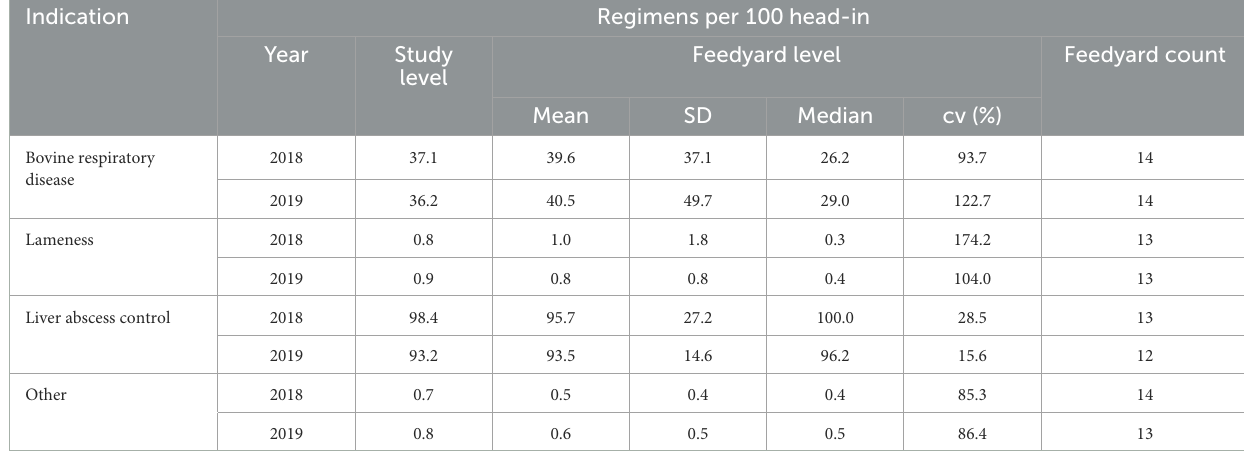
TABLE 8 Medically important antimicrobial regimens per 100 head-in by indication at the study and feedyard level. Indication